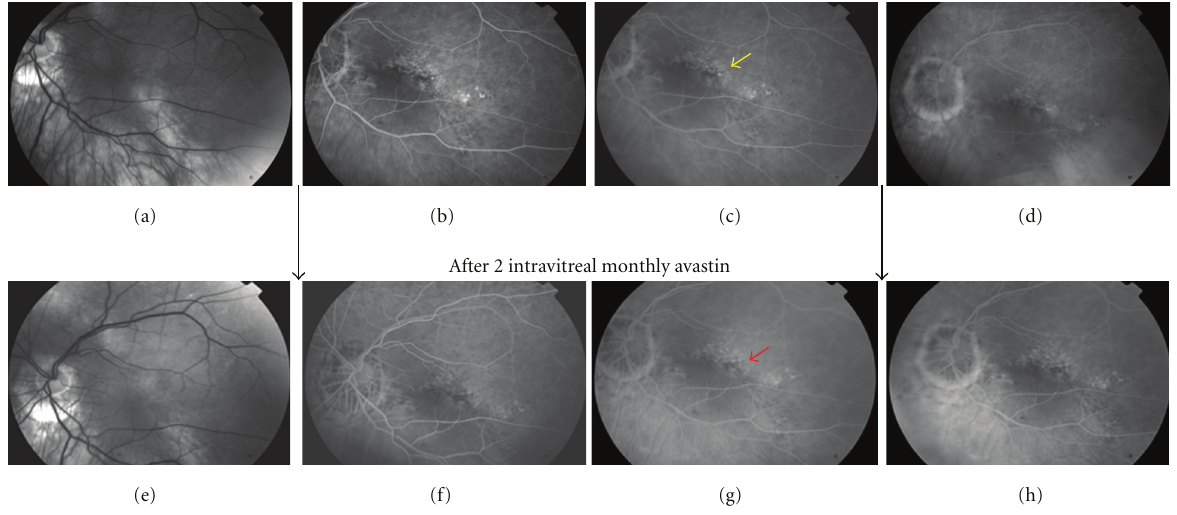
Figure 1: (a), (b), (c), (d): imaging before intravitreal bevacizumab. (e), (f), (g), (h): imaging after intravitreal bevacizumab. Red free picture (a) shows tilting of optic disk with inferior staphyloma. RPE pigmentary changes are evident along the staphyloma area. In early mid-phases of fluorescein angiography (b, c) an hyperfluorescent dot (yellow arrow) becomes evident over a background of di ff use oblique-oriented RPE atrophy that typically overlies the staphyloma. At 5-minutes late phase (d) leaking point intensity dissolves into a di ff use vanishing hyperfluorescence. After treatment the primitive leaking dot (red arrow) is not detectable in early (f), middle (g), or late phases (h) of fluorangiography.